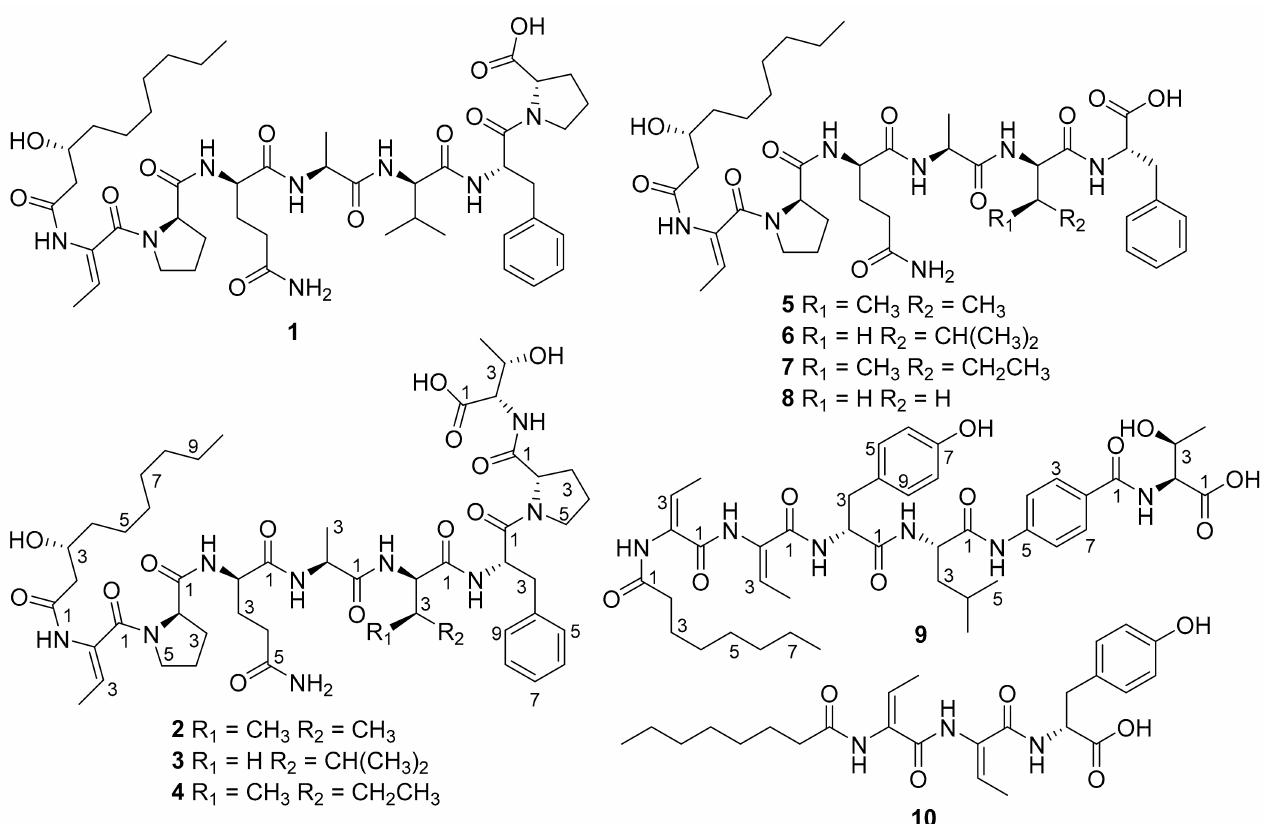
Figure 1. Structures of compounds 1 – 10